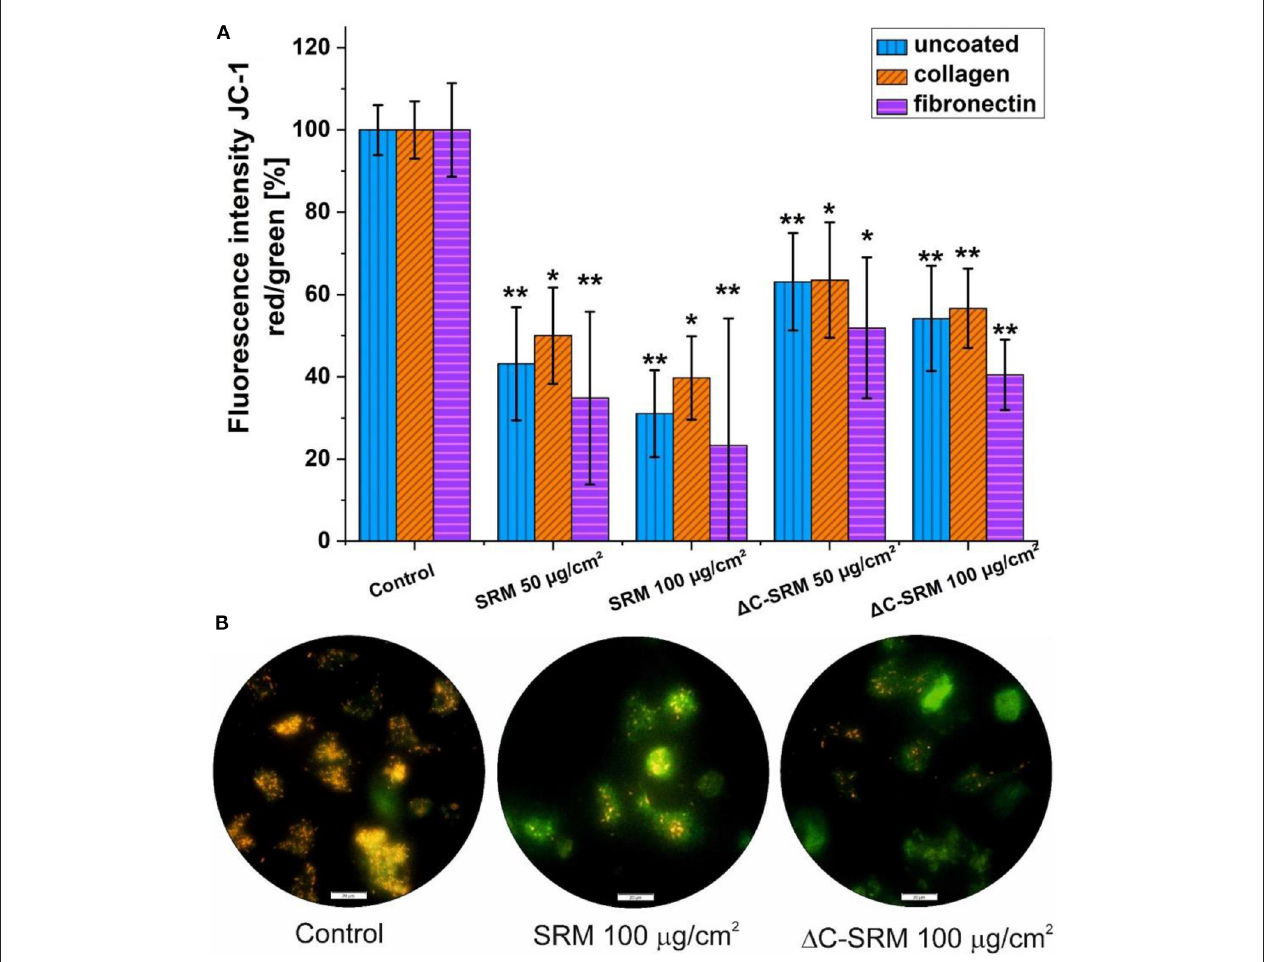
FIGURE 6 | (A) The changes in mitochondrial membrane potential ( 19 m) in A549 cells after 24-h incubation on particulate matter (PM)-covered plates either uncoated or coated with fibronectin/collagen measured using JC-1 probe (exposure method 2). (B) Representative images of depolarization of 19 m of A549 cells induced by PM. Scale bar is 20 µ m; * p < 0.05, ** p <